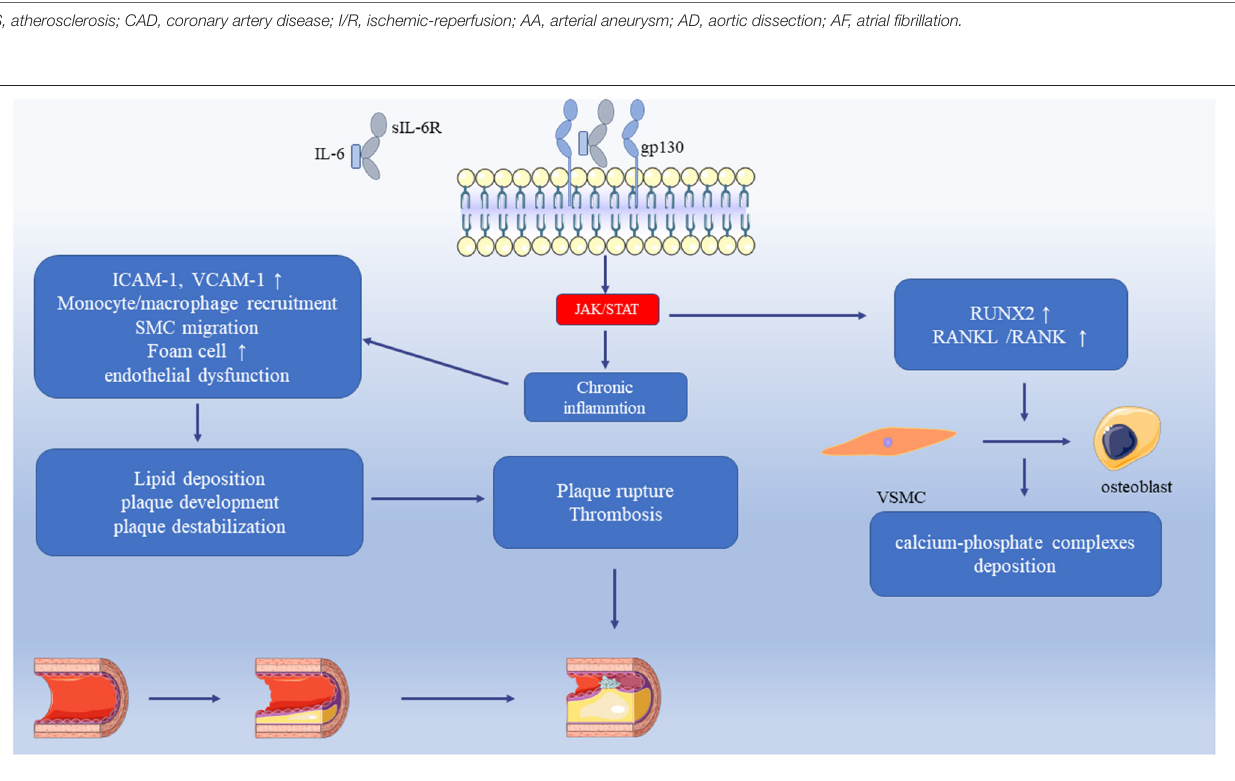
FIGURE 1 | The relationship between IL-6 and atherosclerosis, MI, and vascular calcification. The IL-6 trans-signaling activates the JAK/STAT pathway that leads to chronic inflammation. It increases the adhesion molecules in the vasculature, endothelial dysfunction, the recruitment of monocytes/macrophages, and SMC migration. Monocytes uptake LDL and transform into foam cells that accelerate the progression of atherosclerosis. These pathological processes cause lipid deposition, plaque development, and plaque destabilization. With increasing severity of atherosclerosis, the plaque ruptures, and thrombosis result in myocardial infarction. IL-6 upregulates RUNX2 and RANKL/RANK, which induces the differentiation of VSMC to osteoblast and then induces the calcium-phosphate complexes deposition. JAK, Janus Kinase; STAT, Signal transducers and activators of transcription; LDL, Low-density lipoprotein; RUNX2, Runt-related transcription factor 2; RANKL, Receptor activator of NF- κ B ligand; SMC, Smooth muscle cell; VSMC, Vascular smooth muscle